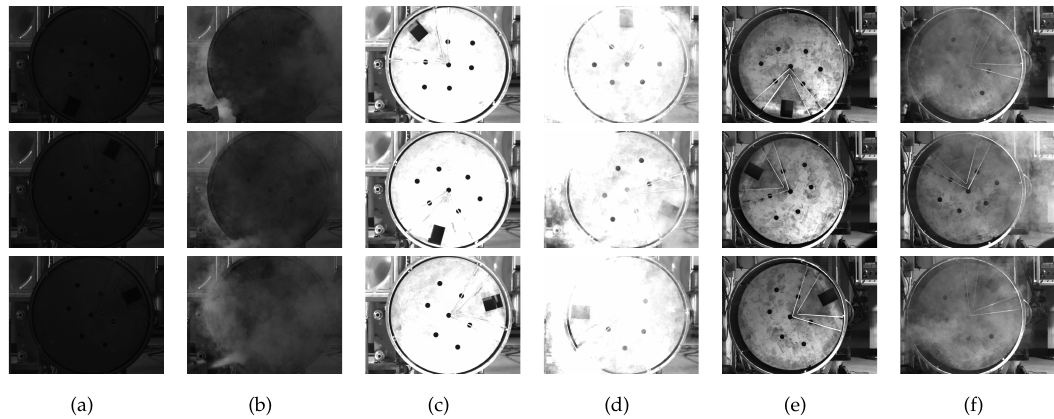
Figure 14. The categories of training images: ( a ) low brightness images without dust, ( b ) low brightness images with dust, ( c ) high brightness images without dust, ( d ) low brightness images with dust, ( e ) normal brightness images without dust, ( f ) normal brightness images with